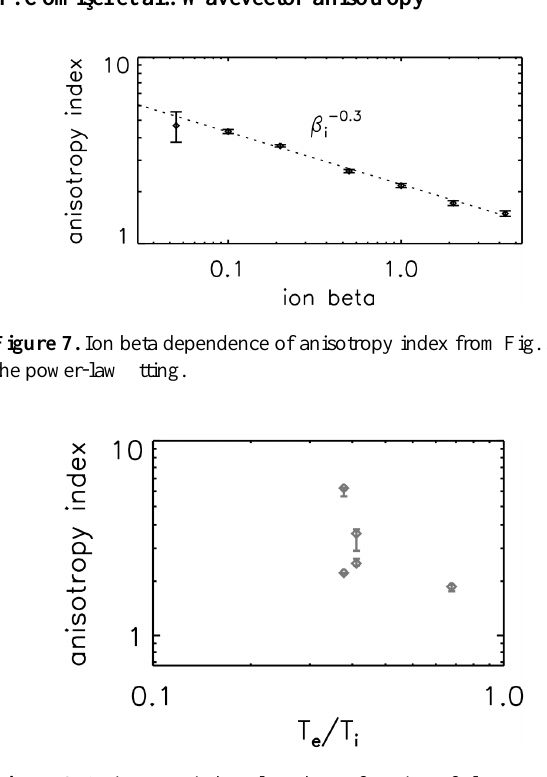
Figure 8. Anisotropy index plotted as a function of electron-to-ion temperature ratio as measured by the Cluster spacecraft in the solar wind.